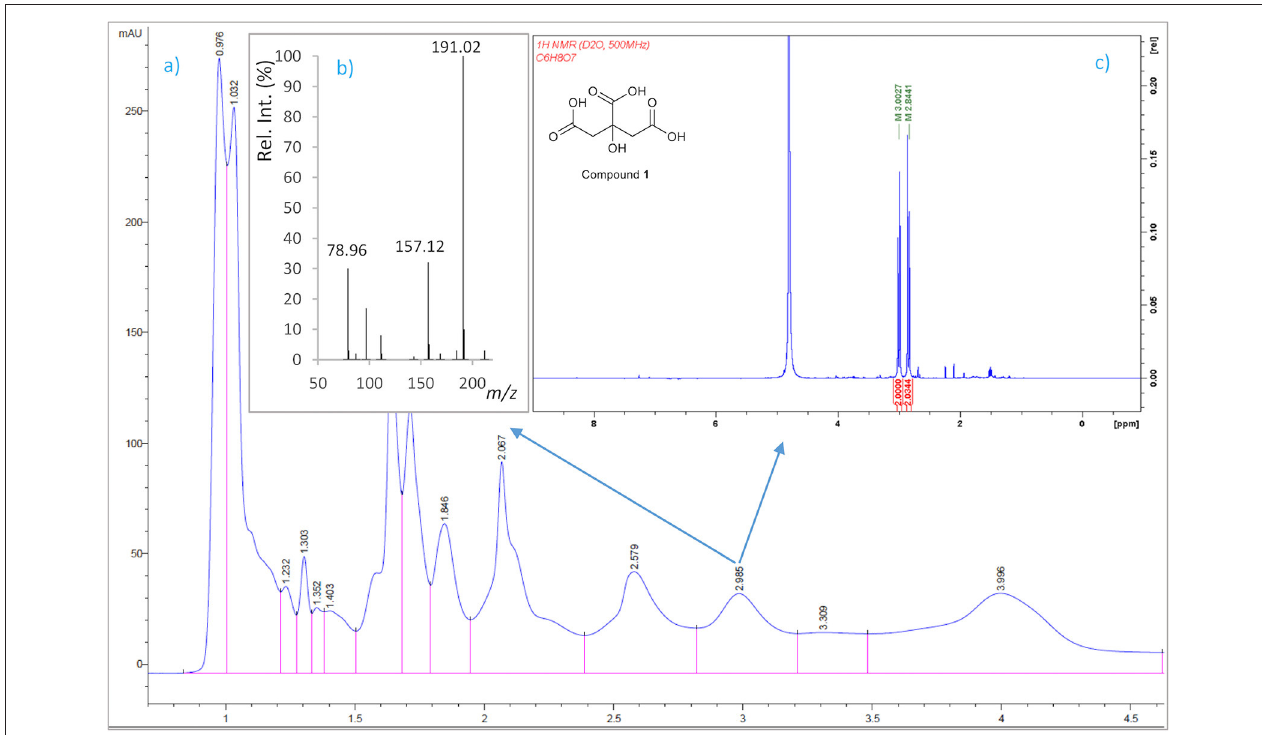
FIGURE 7 | Isolation by HPLC and chemical analysis of compound 1 : (a) HPLC chromatogram of the CAS active and salt-free fraction eluted from the Sephadex ® G-10 column. (b) ( − )ESI mass spectrum and (c) 1 H NMR spectrum in D 2 O (500 MHz) of compound 1